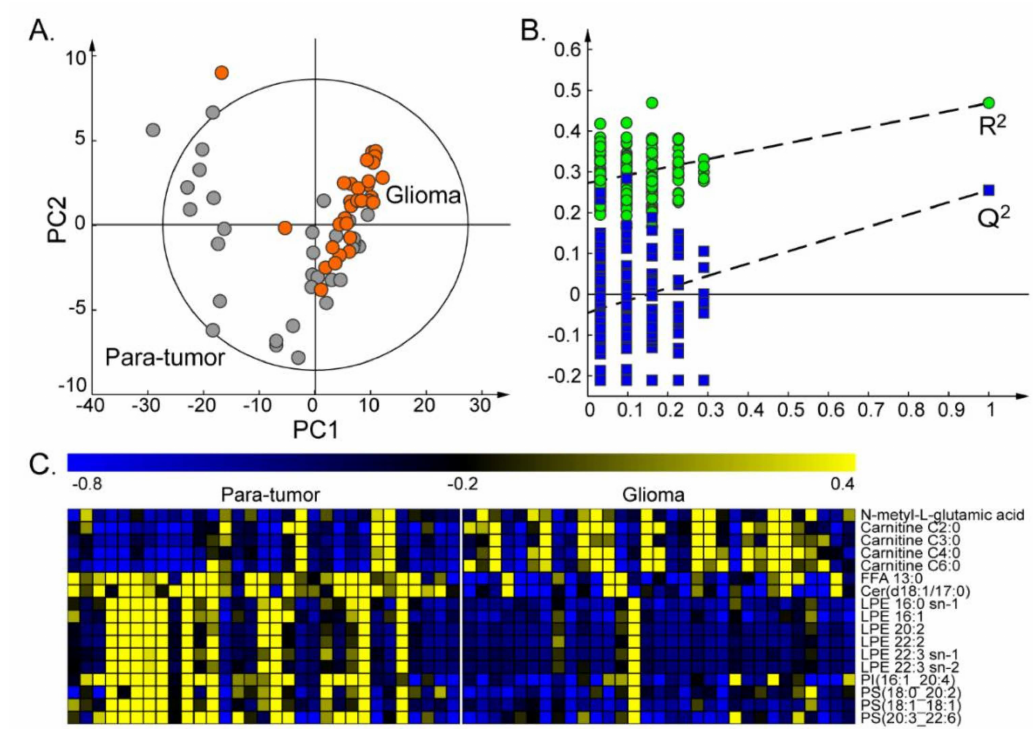
Figure 2. Statistical analysis for all paired glioma and para-tumor tissues. ( A ) Partial least squares discriminant analysis (PLS-DA) score plot based on all di ff erential metabolites for gliomas (orange dots) versus para-tumor tissues (gray dots). ( B ) Model validation using a permutation test. ( C ) Heatmap showing the relative levels of the 17 important metabolites in all paired para-tumor and tumor tissues.